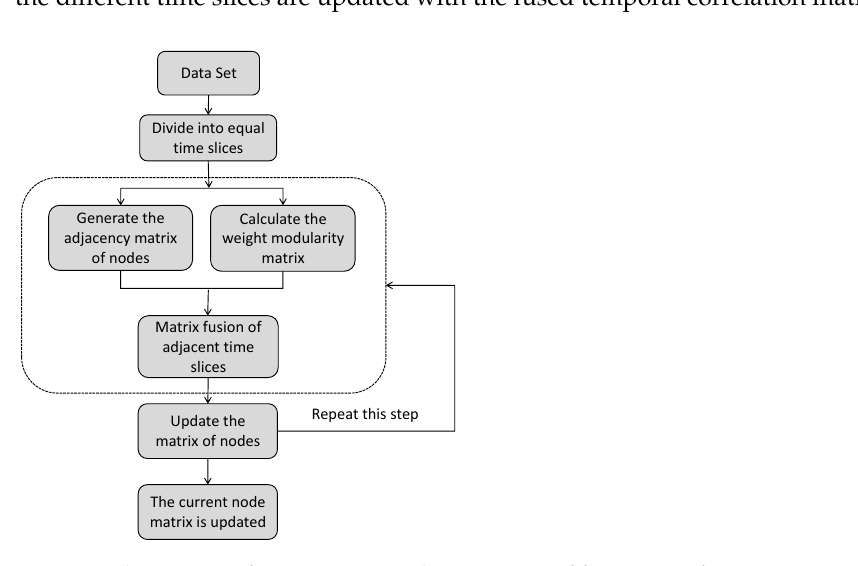
Figure 7. The process of generating correlation matrix of fusion time feature.